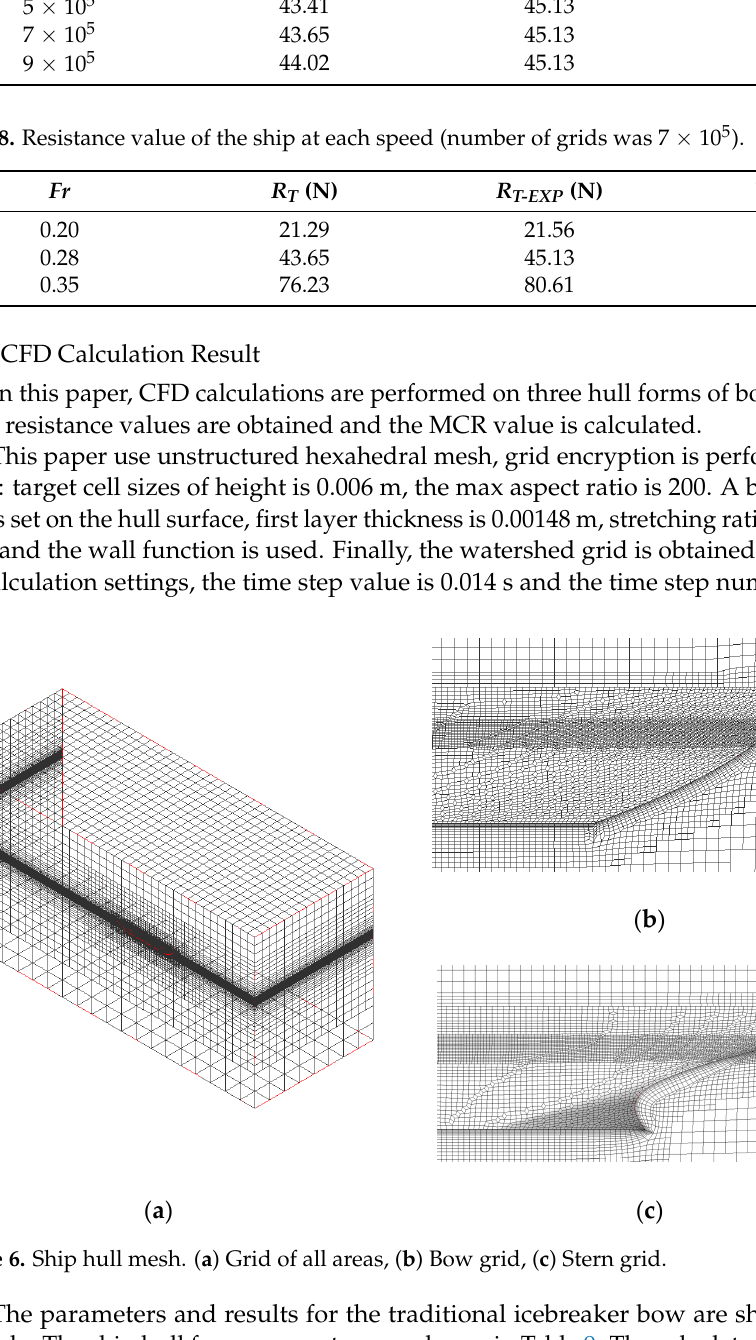
Figure 7. Water surface wave height. Table 9. Main parameters of traditional icebreaker ship model (scale ratio α = 40). Name